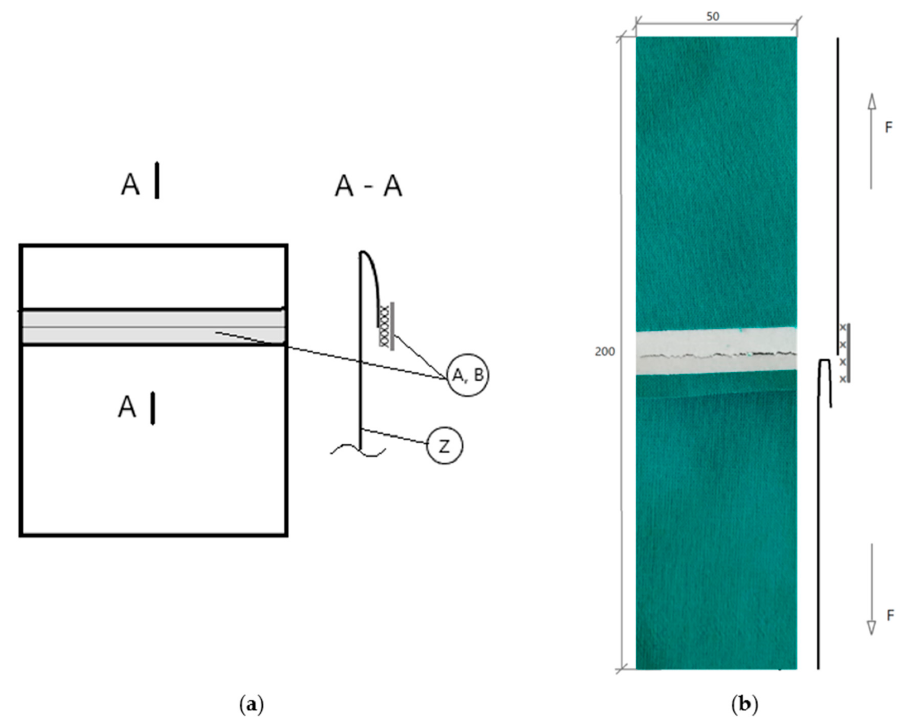
Figure 1. ( a ) Technological project of seam structure in finishing the bottom edges of pocket—the hem laminated seam of 6.03.k type (the cross-section and views); A—StripFlock tape; B—reflective tape; Z—fabric; ( b ) Determination of the strength of seams oriented perpendicular to the direction of force (delamination test).